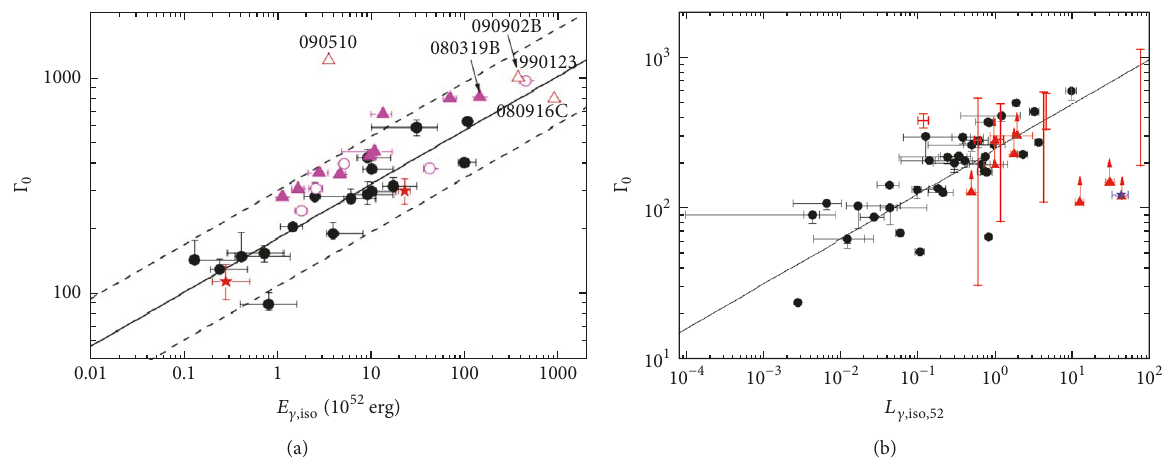
Figure 5: (a) log Γ 0 -log 𝐸 relation with the addition of GRBs with an onset trend in the X-ray band (GRBs 070208 and 080319C; red prompt stars), Γ 0 computed by RS peaks or probable afterglow peaks (pink open circles), lower values of Γ 0 obtained from single power law decay light curves (pink solid triangles), and strong lower values of Γ 0 for Fermi /LAT GRBs 080916C, 090902B, and 090510 (red open triangles) calculated from opacity limits with Fermi /LAT observations. The solid line indicates the best fit of the Γ 0 - 𝐸 The two dashed lines represent the 2𝜎 deviation, where the standard deviation of the ratio Γ 0 /𝐸 0.25 after Liang et al. [164]; see Figure 8 therein. @ AAS. Reproduced with permission.) (b) log Γ 0 versus log 𝐿 given by log Γ 0 ≃ 2.40 + 0.30 log 𝐿 with 𝑟 = 0.79 . The triangles represent the bursts with only lower values and the star indicates the only iso short burst in the sample, GRB090510. (Figure after L¨u et al. [143]; see Figure 2 therein. @ AAS. Reproduced with